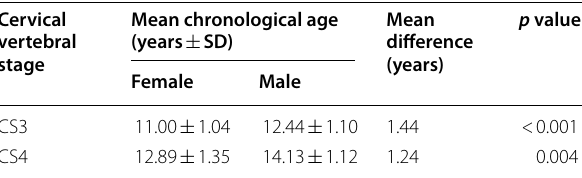
Table 4 Comparison of the onset and termination age of adolescent growth peak between two genders (independent samples t